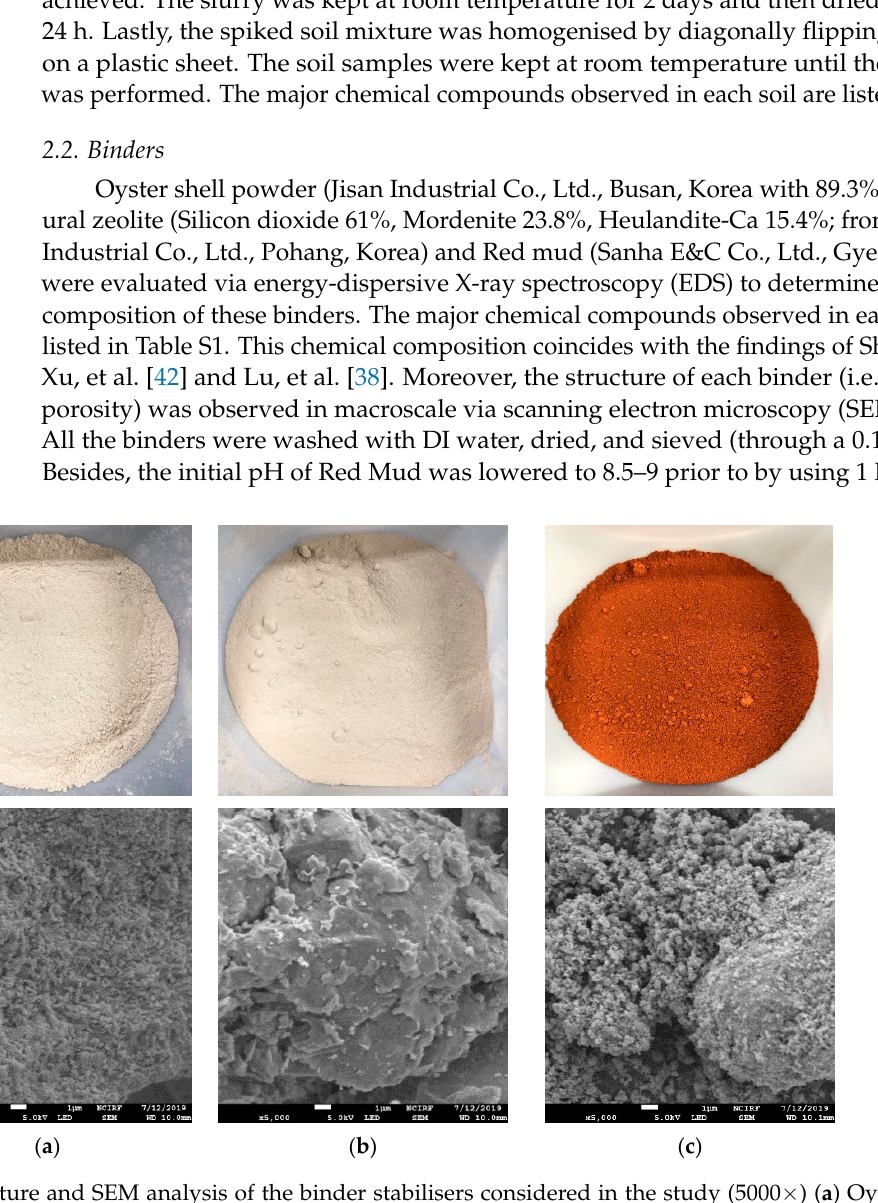
Figure 1. Materials texture and SEM analysis of the binder stabilisers considered in the study (5000 × ) ( a ) Oyster shell powder (OS); ( b ) Zeolite (Z) and ( c ) Red Mud (RM).